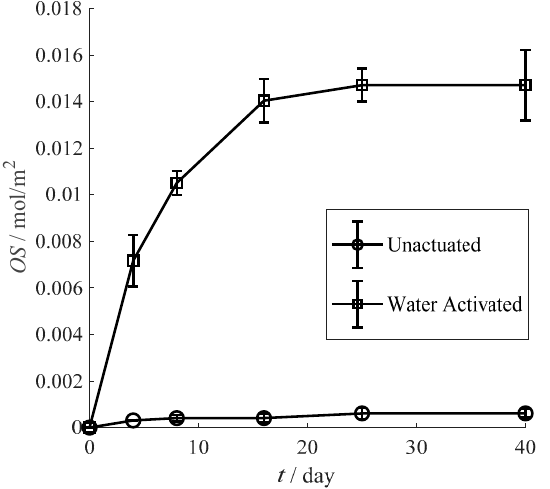
Figure 7. Influence of activating condition on the oxygen scavenging performance.